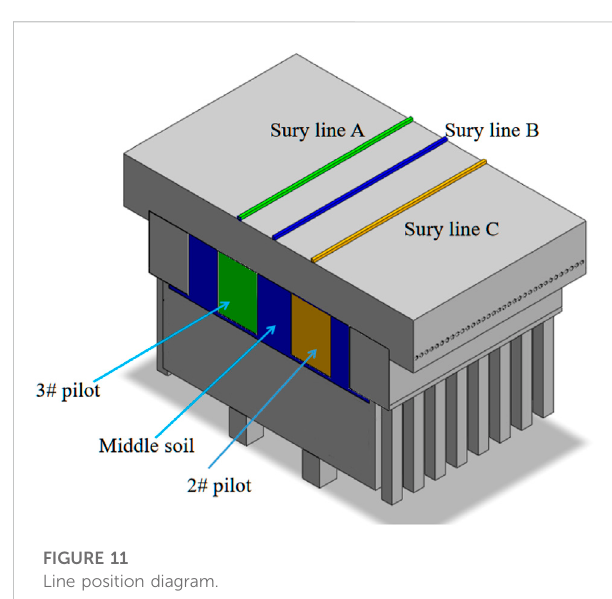
FIGURE 11 Line position